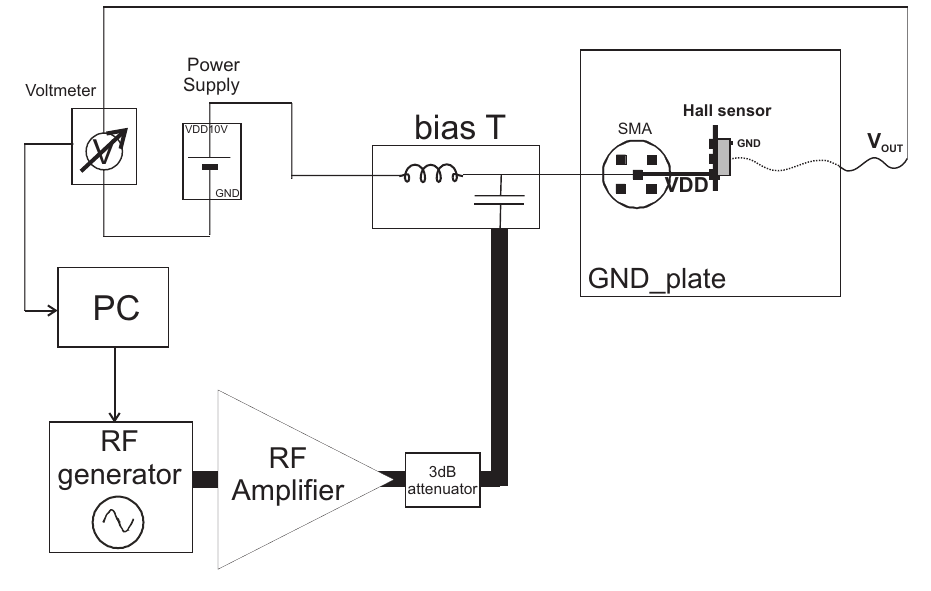
Figure 14. DPI on Hall sensor VDD Test setup